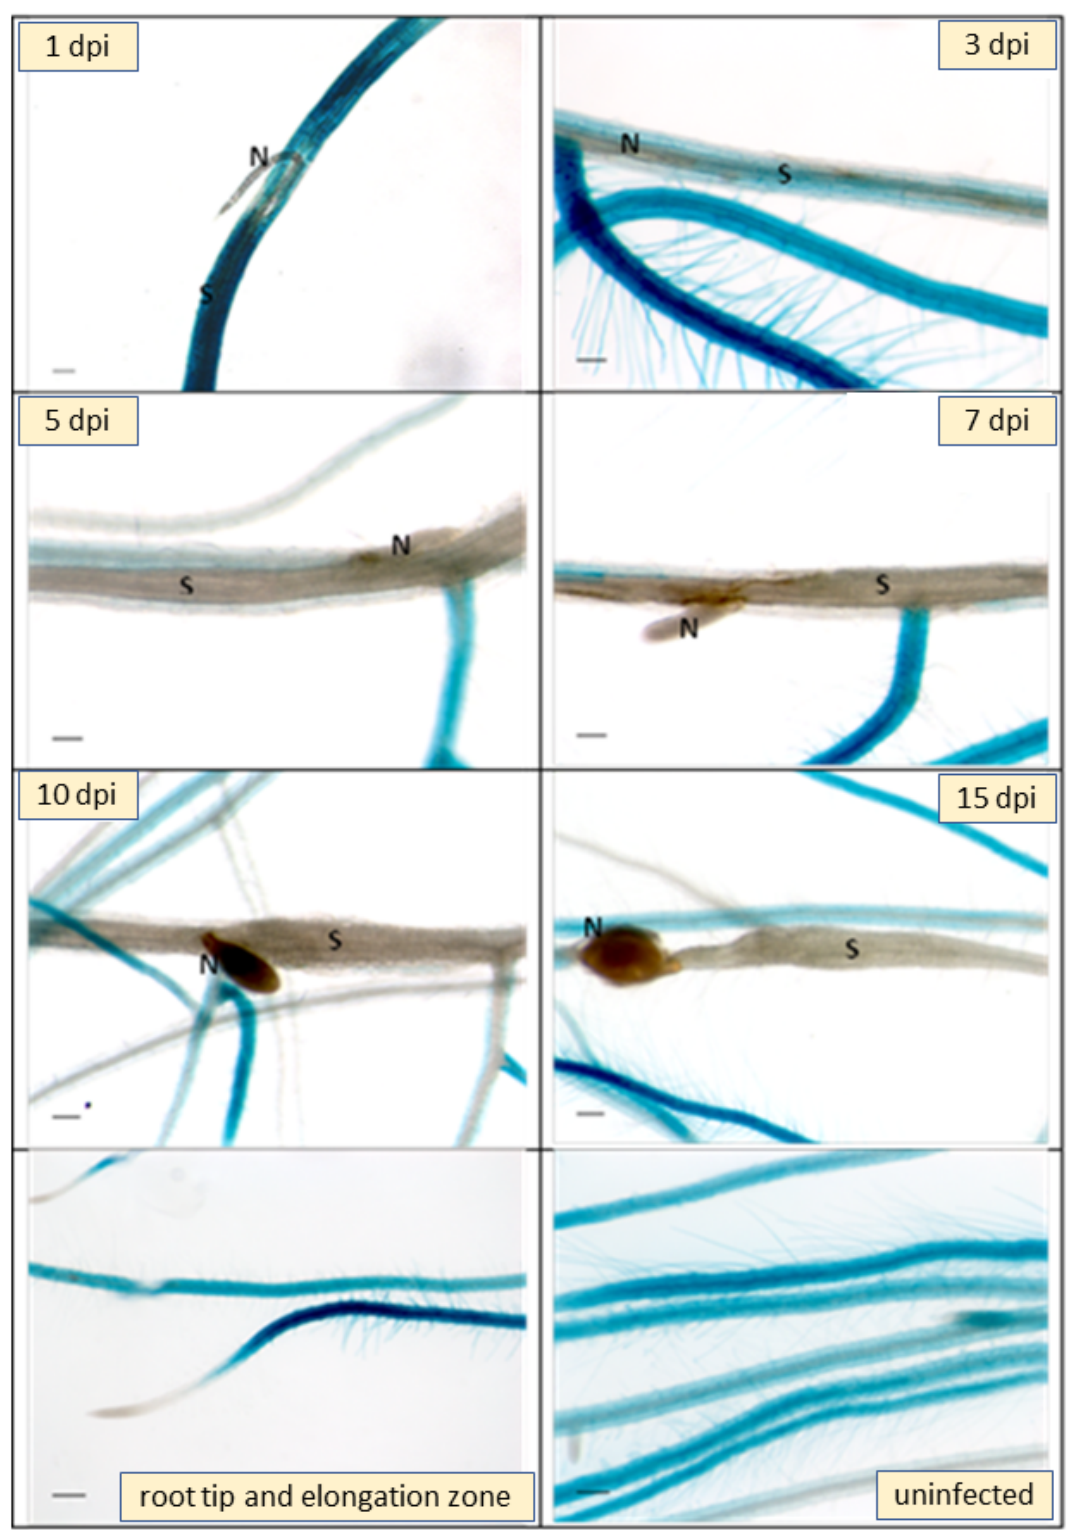
Figure 7. GUS expression in a At3g59930::GUS transgenic line infected with H. schachtii . Plants were grown on Knop medium. The figure shows infection sites on roots at 1, 3, 5, 7, 10 and 15 dpi (days post infection). At the bottom uninfected roots and root tips with elongation zone are shown. Downregulation of GUS expression at infection sites starts as early as 1 dpi. S, syncytium; N, nematode. Bar = 100 μm.